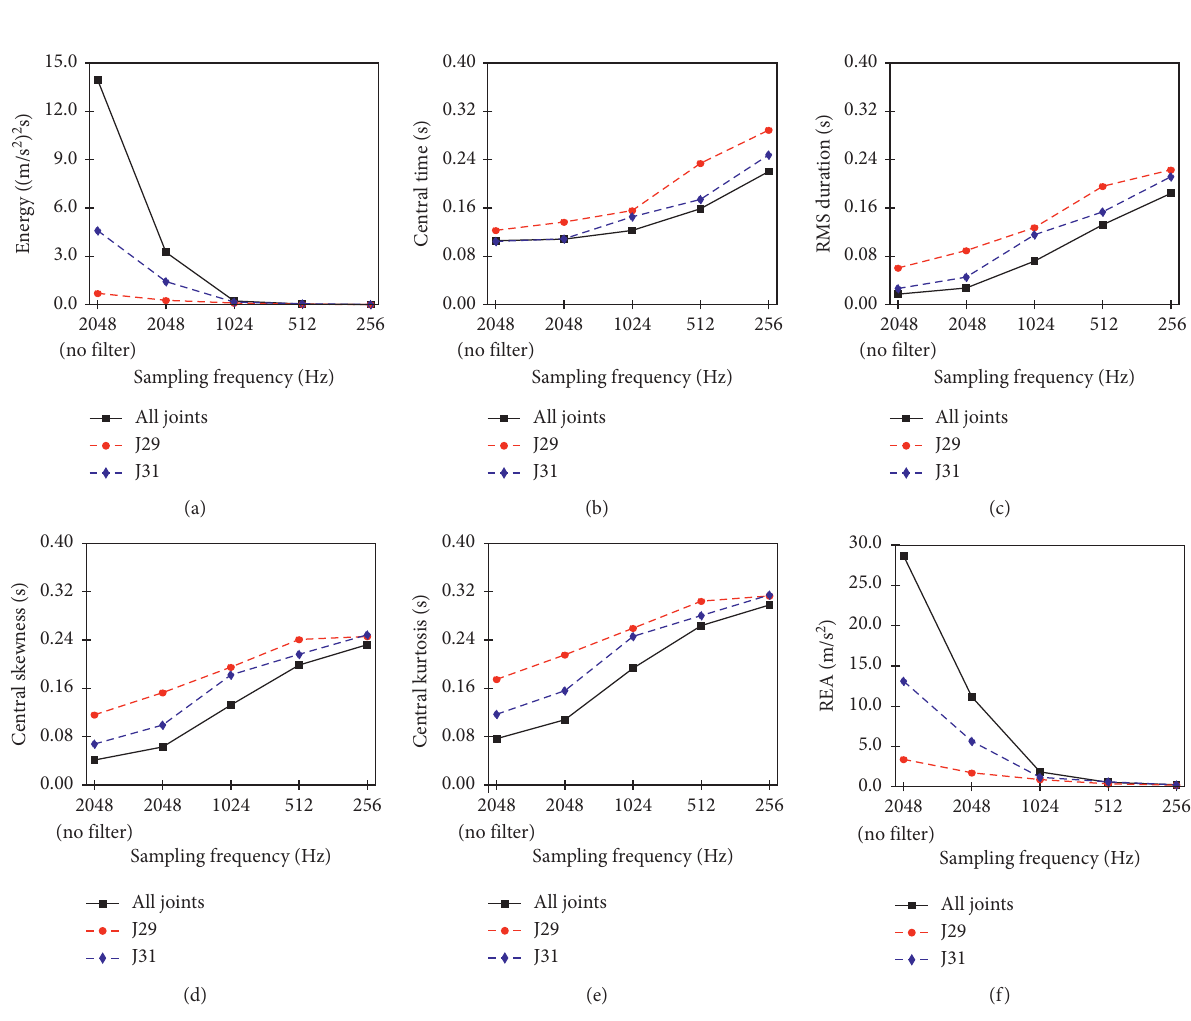
Figure 10: Analysis results for different sampling frequencies. Table 4: Absolute value of percentage change in the damaged joints to the value of all joints. Statistical